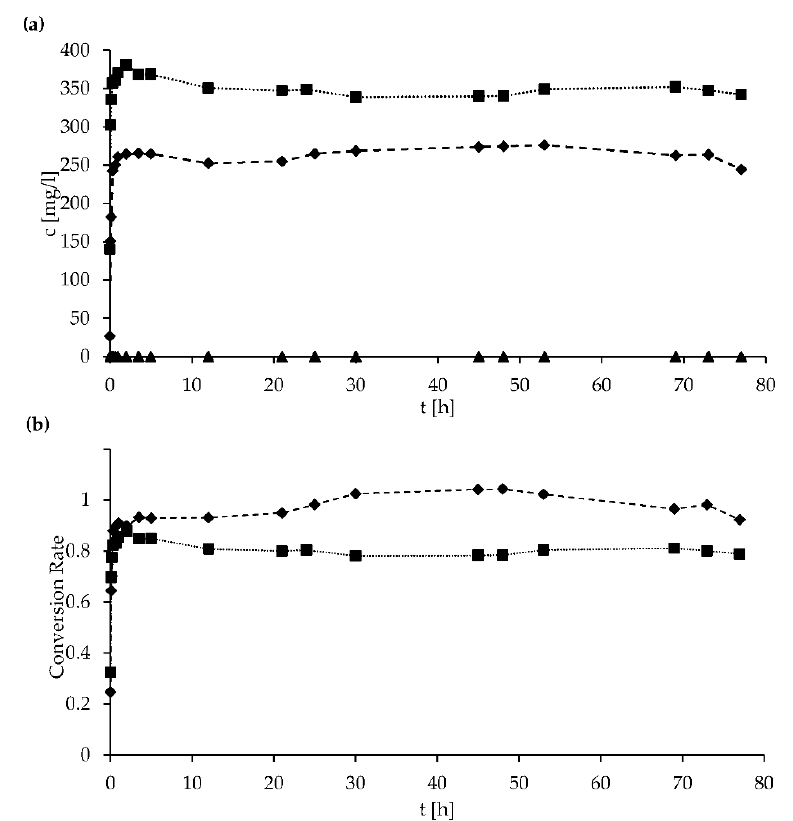
Figure 2. Temporal course of concentrations ( a ) and conversion rates ( b ). Aqueous sugar beet fiber extract was pumped through the system at a flow rate of 0.25 mL min − 1 and samples were taken after each process step. The concentrations were quantified via HPLC. ( a ) c–concentration of the respective products of the enzymatic conversion, c FA after hydrolysis with Rs p CAE, c 4-VG after decarboxylation with ScoFAD, c 4-VG after extraction with XAD4. ( b ) Rs p CAE, ScoFAD.